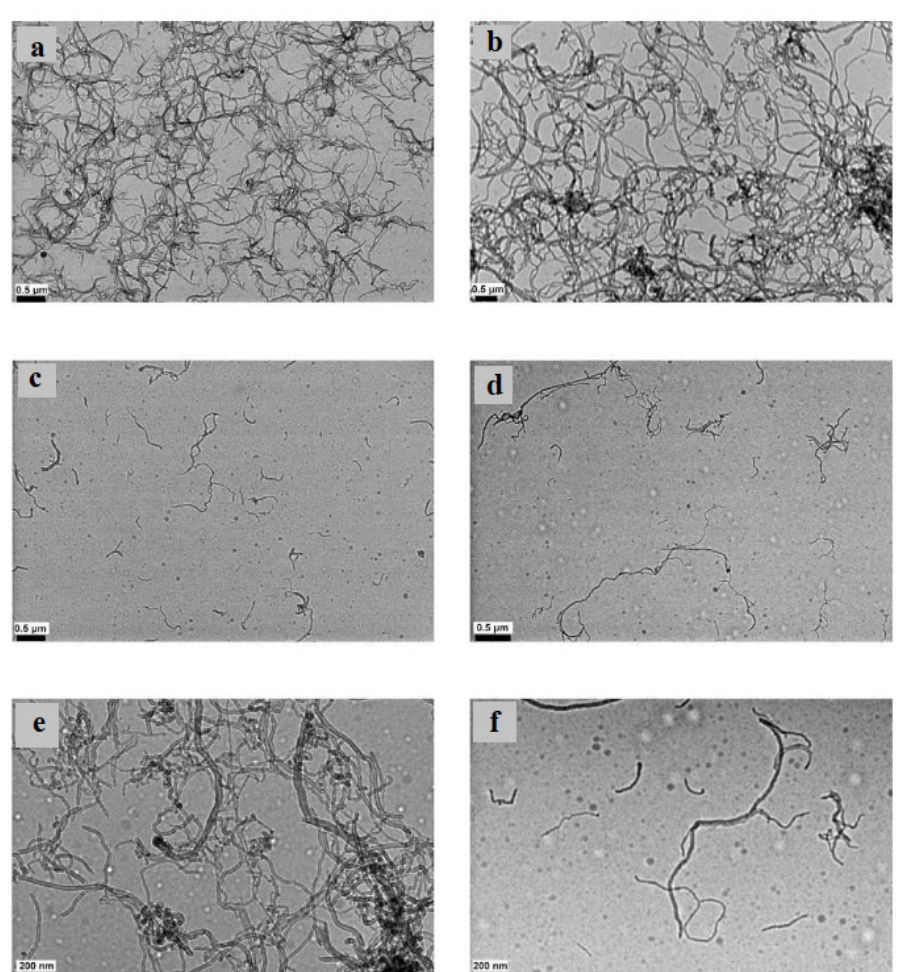
Figure 7. Images of Wet-TEM of 1 wt% MWCNT + 0.25 wt% GA NF sonicated for: ( a ) 20 min at 0.5 μ m scale, ( b ) 40 min at 0.5 μ m scale, ( c ) 60 min at 0.5 μ m scale, ( d ) 80 min at 0.5 μ m scale, ( e ) 40 min at 200 nm scale, and ( f ) 80 min at 200 nm scale. Adapted from [155].